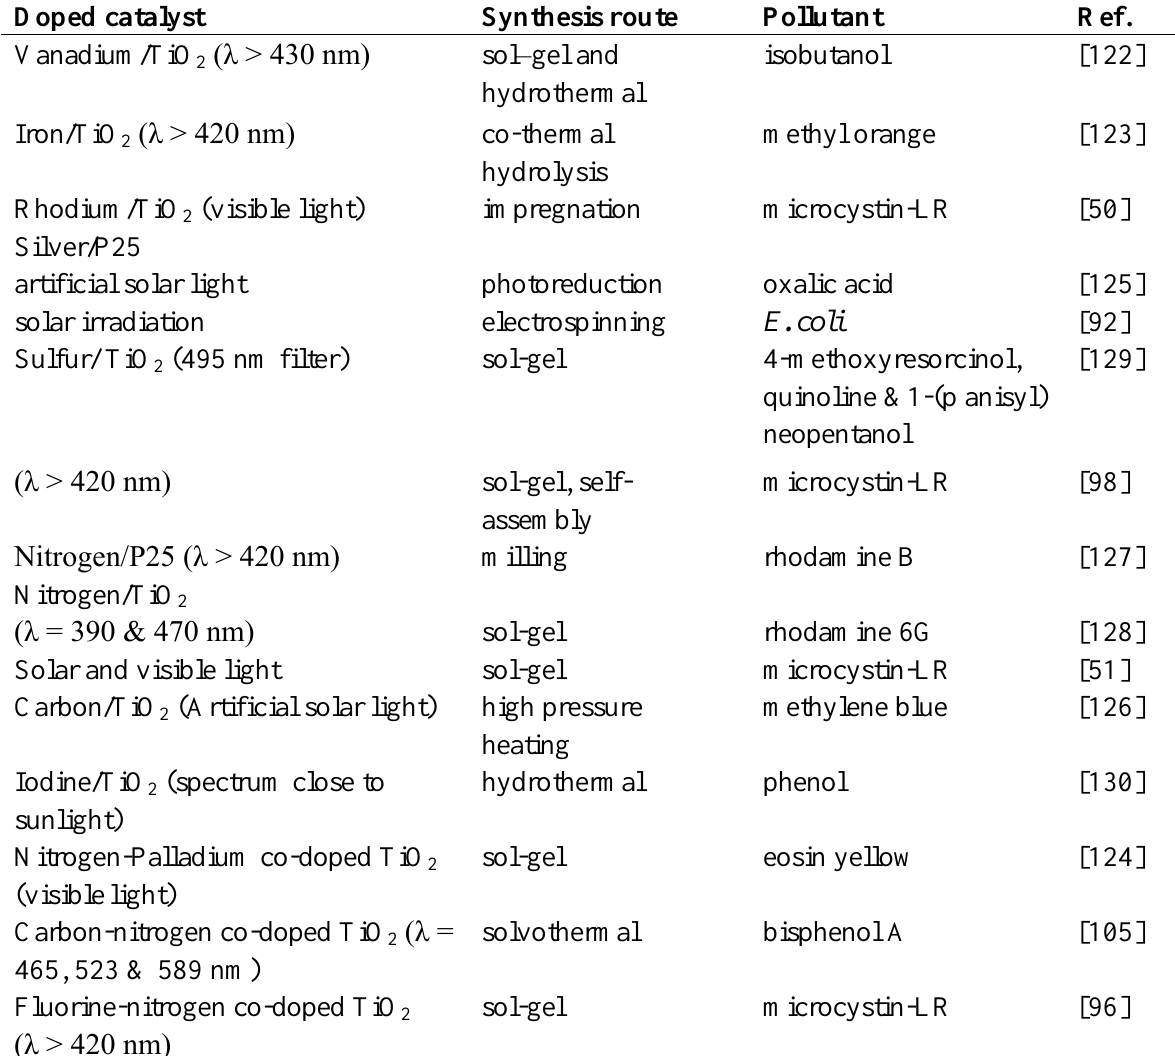
Table 3. Recent examples of metal- and non-metal-doped NTO